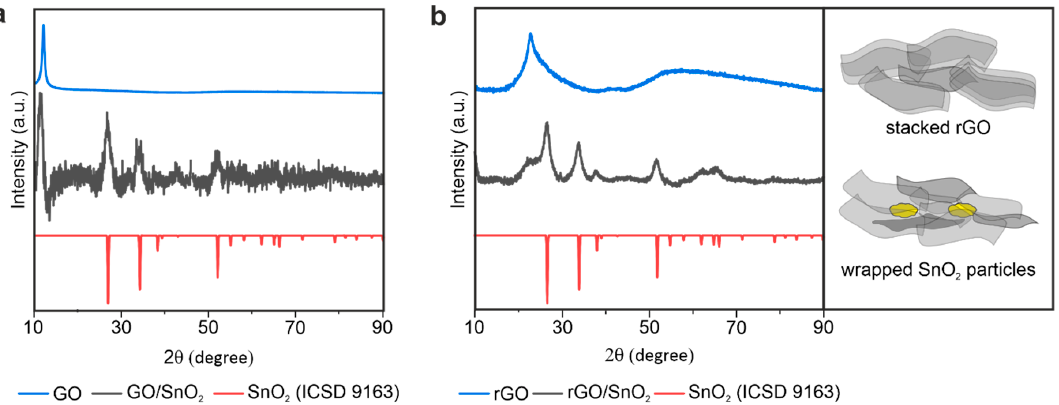
Figure 3. XRD pattern of the ( a ) GO / SnO 2 and ( b ) rGO / SnO 2 hybrid aerogel with a schematic presentation of the rGO sheets arrangement with and without SnO 2 particles.